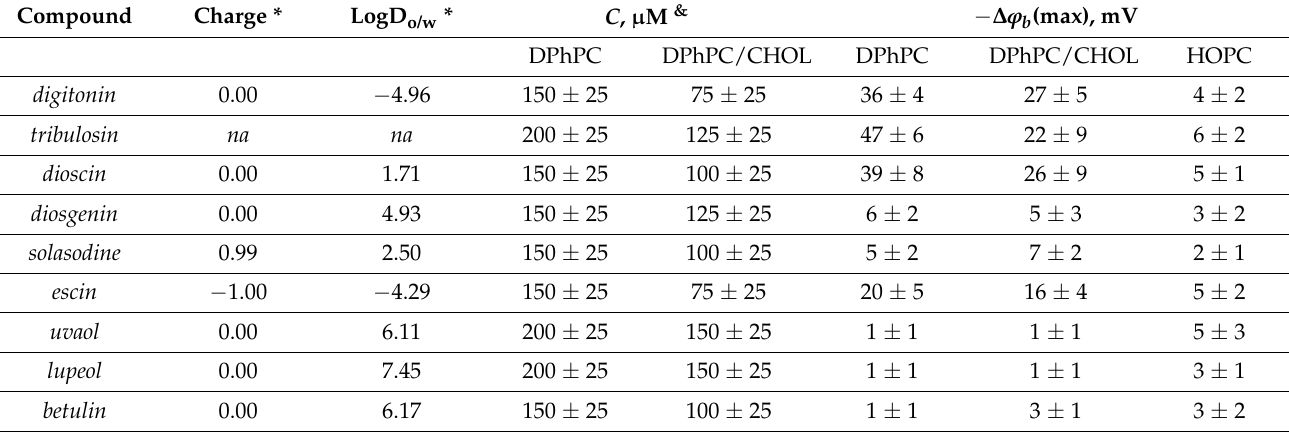
Table 1. The characteristic parameters of the action of the tested compounds on the electrical properties of the model lipid membranes.